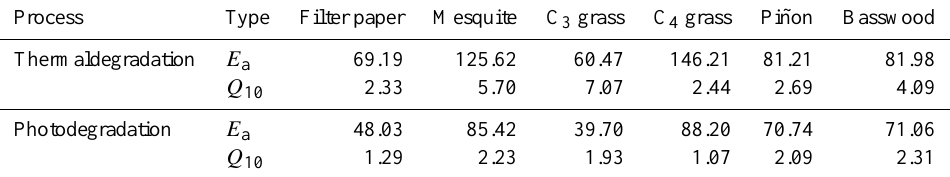
Table 1. The activation energy ( E a :kJmol − 1 ) and the Q 10 values of H 2 production during thermal degradation and photodegradation of litter for the six plant litter types calculated by Arrhenius equation over the 15 to 80 ◦ C temperature range for E a and 25 to 55 ◦ C temperature range for Q 10 .